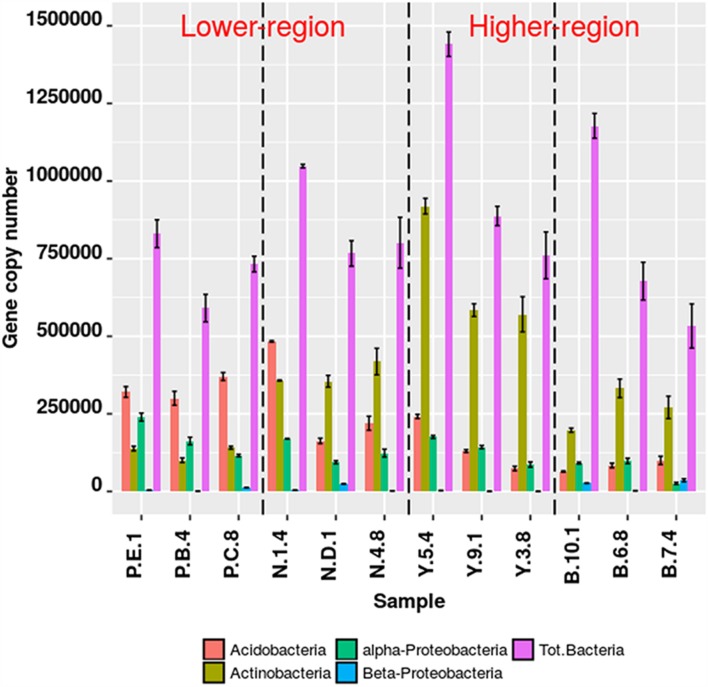
Bacterial gene abundance (copy number) from rhizospheric soil at different altitudes. Specific detection of bacterial groups by qPCR using taxon specific primers. Absolute gene copy numbers were determined from 5 ng of template DNA dilution curve series with known standards. Error bars are one standard error of the mean (SEM) of replicate qPCR reactions (n ≥ 3).